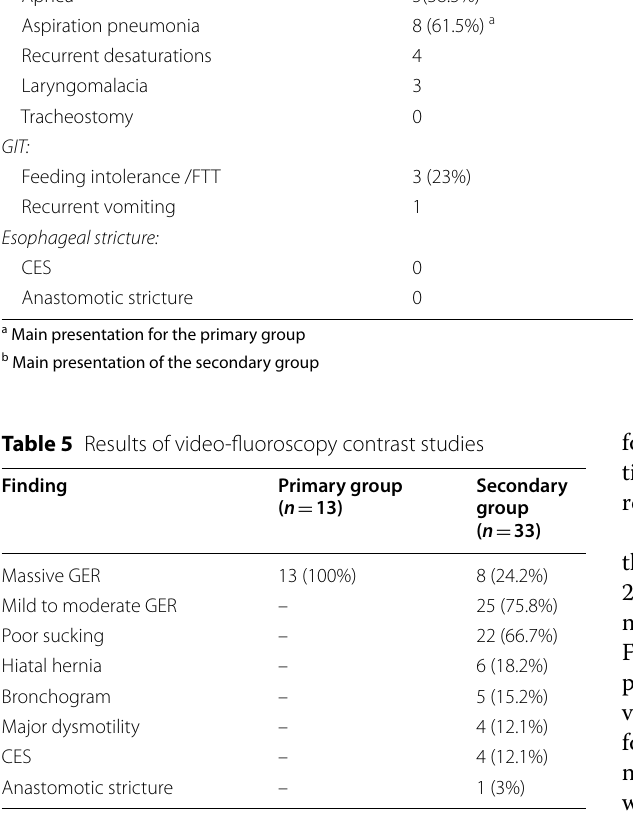
Table 4 Summary of patients’ presentations